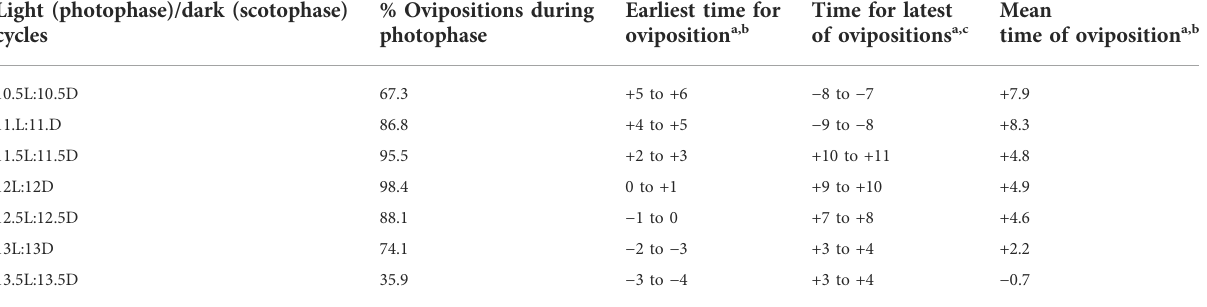
Earliest time for Time for latest Mean oviposition a,b of ovipositions a,c time of oviposition